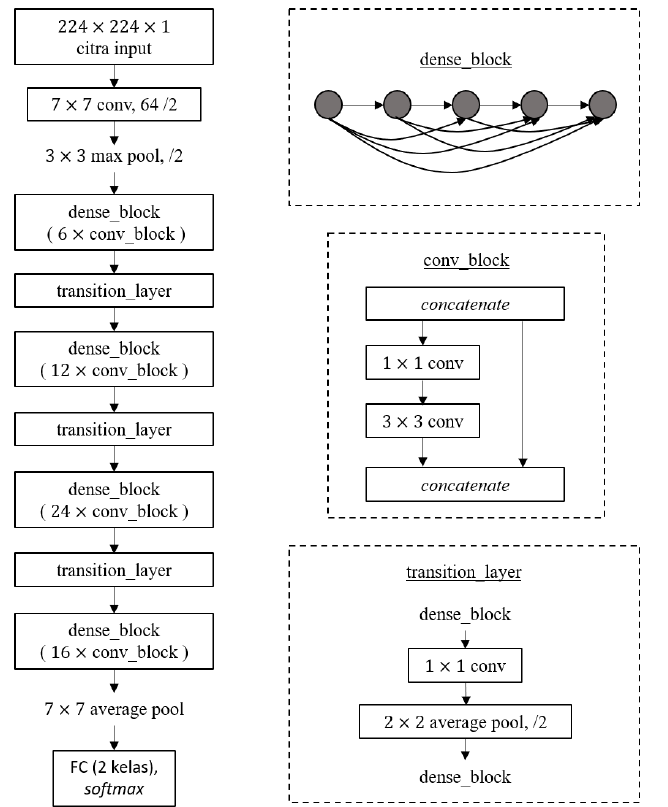
Figure 7. DenseNet121 architecture [29].